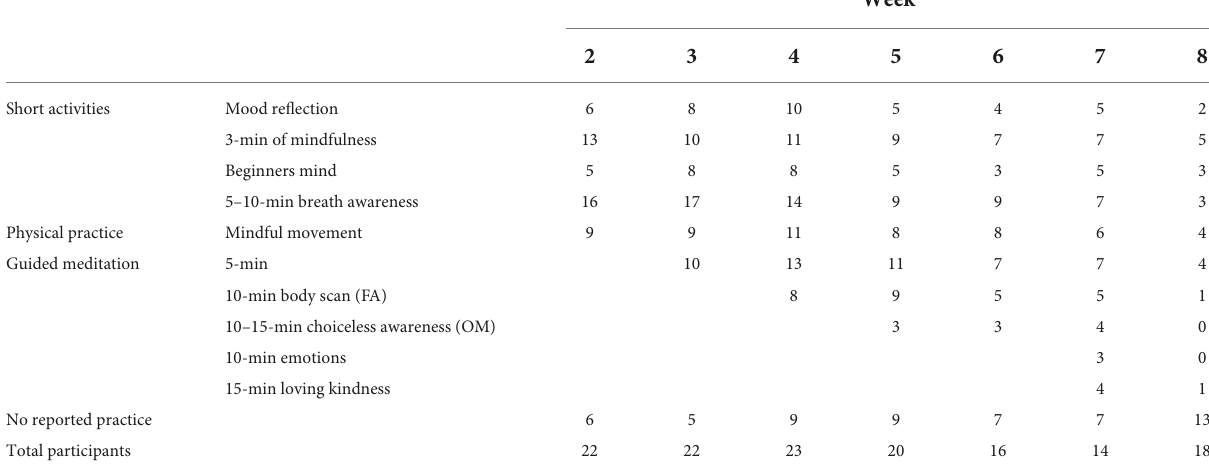
TABLE 3 Home practice—activities and number of